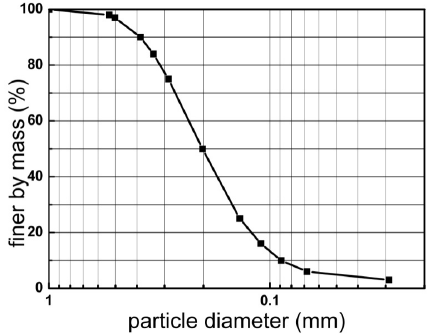
Figure 6. Particle-size distribution of the tested sand.